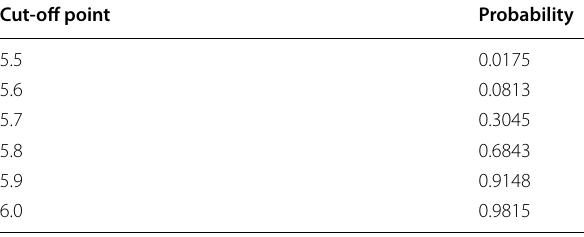
For values greater than 5.7 mm, the probability of presenting intracranial hypertension increases considerably